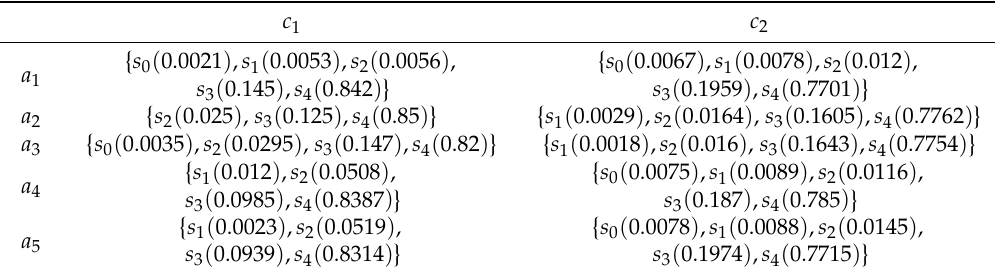
c and 1 c and 1